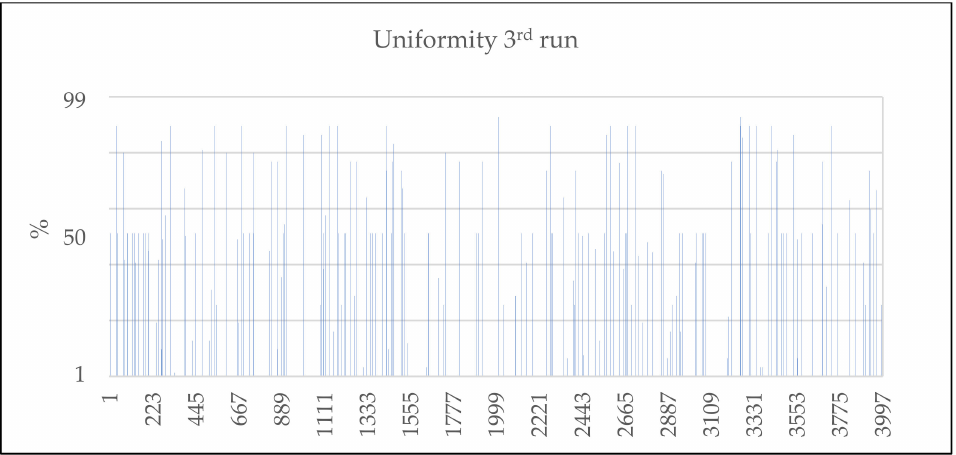
Figure 6. Uniformity of the RC pairs on the second run.